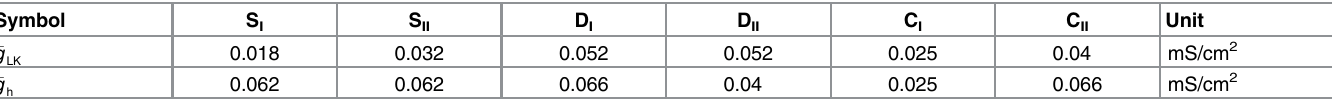
Parameter settings of the isolated thalamus. This table lists the parameter values for the different dynamic regimes of the isolated thalamic module, that are utilized in Fig